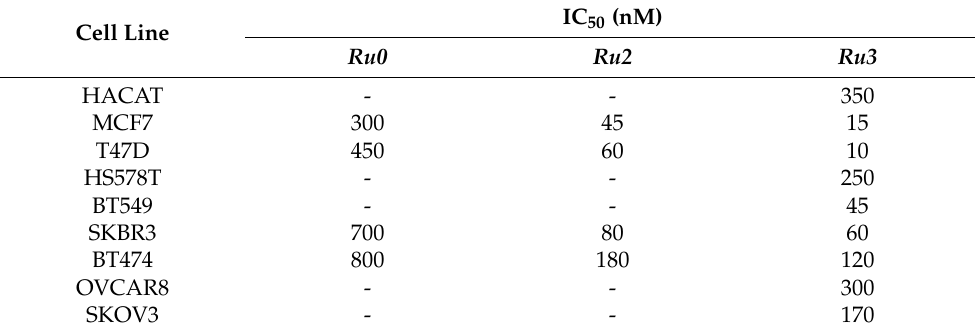
Figure 4. Impact in cell viability of ruthenium compounds at 1 µ M. ( A ) Screening of several ruthenium compounds by exploring cell viability in BT474, SKBR3, T47D, and MCF7 breast cancer cell lines for 72 h evaluated using MTTs. Ru3 displayed the most anti-proliferative activity. The cytotoxic activity was evaluated at 1 µ M for 72 h by MTT metabolization between Ru0, carboplatin, and cisplatin in HER2+ ( B ) and luminal ( C ) cell lines. Data are the average +/ − standard deviation (SD) of three independent experiments performed in triplicate. To determine significant statistical differences, Student’s t -test was used. The values for the statistical analyses are: * p ≤ 0.05; ** p ≤ 0.01. Table 1. IC 50 values of the most active compounds in the different cell